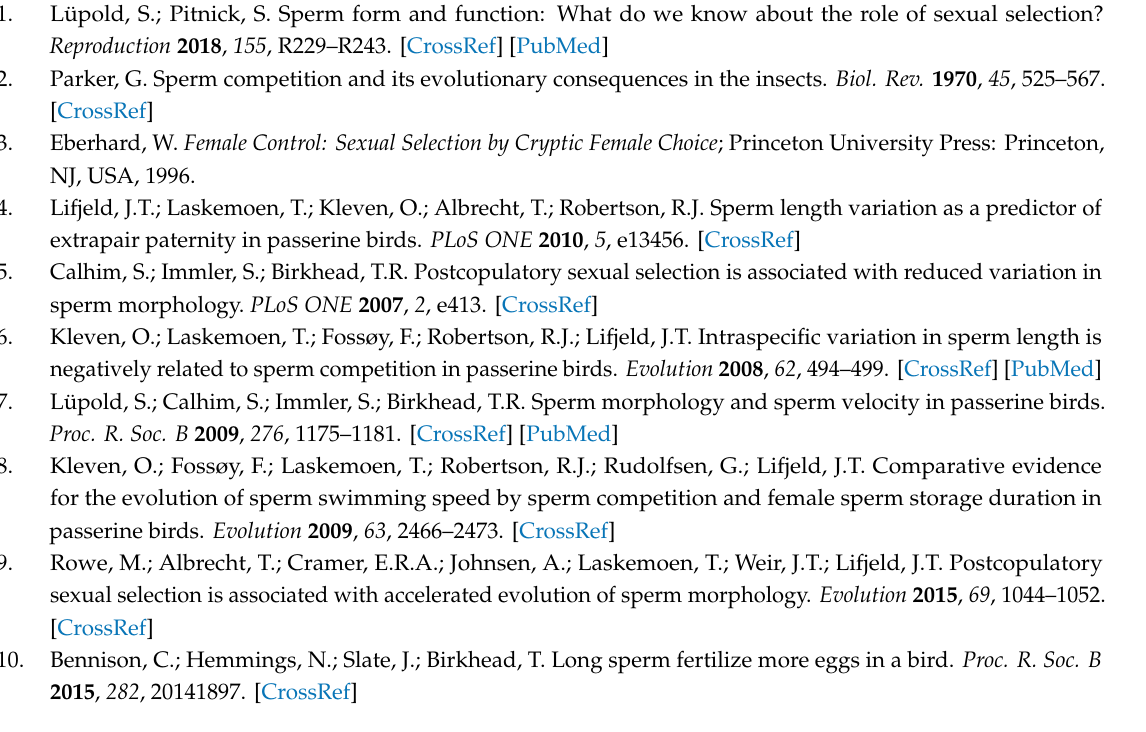
Table S1: Raw data on male characteristics, Table S2: Raw data on sperm morphology used in main analyses, Table S3: Data on sperm morphology used for assessing repeatability, File S1: R code used in